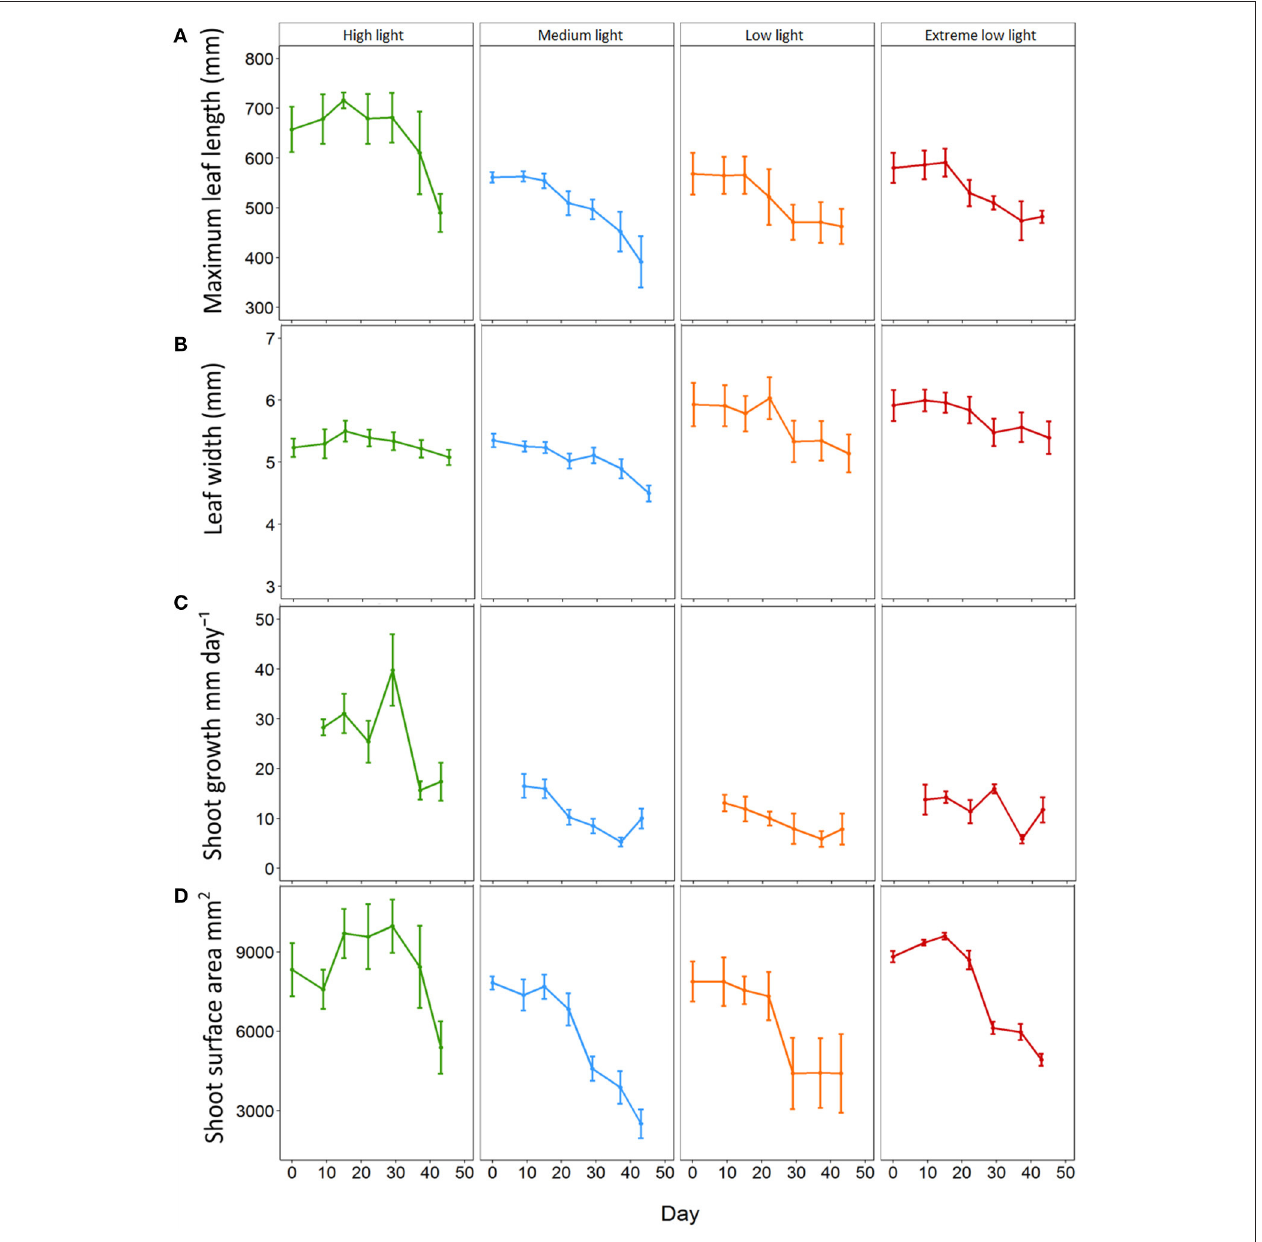
FIGURE 1 | Effect of light shading on the morphological characteristics of Zostera marina over time. Plants were kept in a flow through aquaria using natural filtered seawater under artificial light. (A) Maximum leaf length (B) leaf width, (C) shoot growth and (D) total shoot surface area. Values are means ± SE, n = 5 (except low light plants on days 37 and 45 where n =